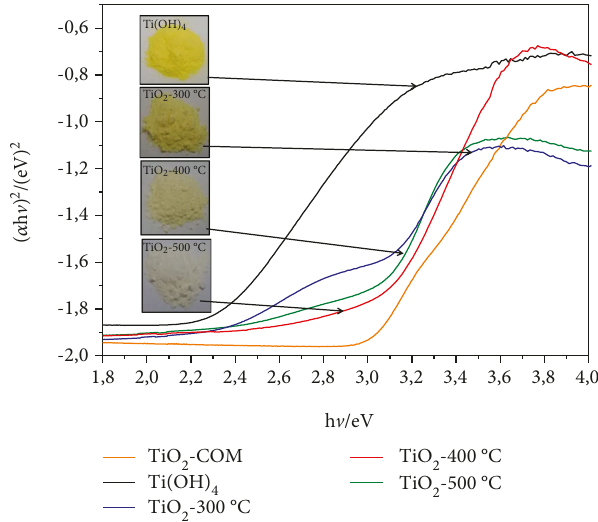
Figure 6: UV-Vis di ff use re fl ectance spectroscopy of catalysts and inset photography of